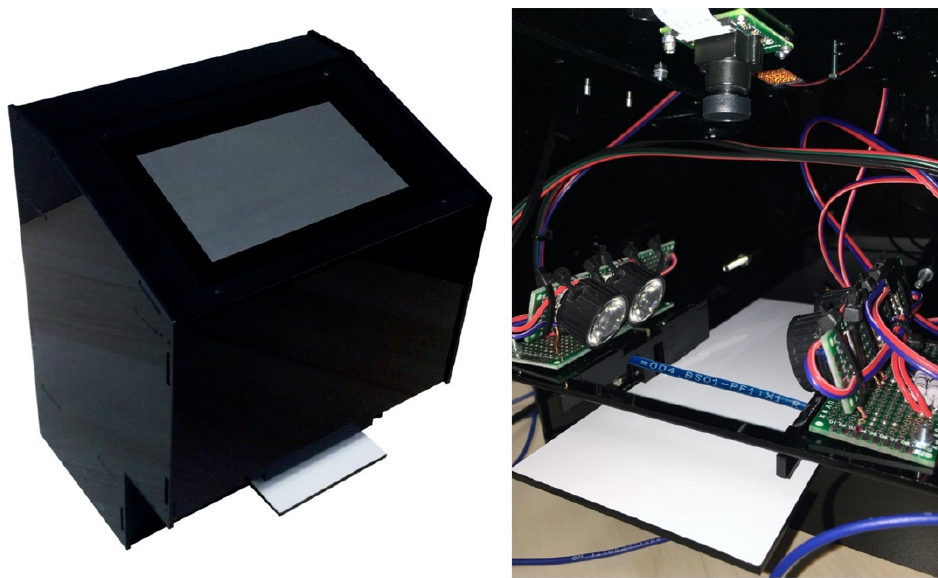
Figure 6. The WLR; the right side of the figure: the front panel of the chassis, removed; above the white background a blue wire, with white font markings, is placed by an operator; LED lamps are above both sides of the white background in order to create perfect exposure; a camera is located on top, directly over the wire.